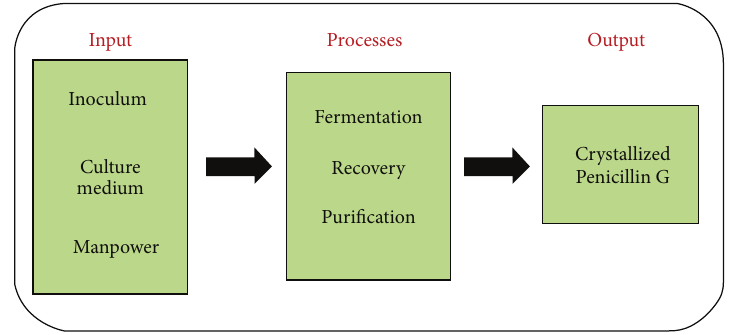
Figure 3: Schematic representation of producing crystallized Penicillin